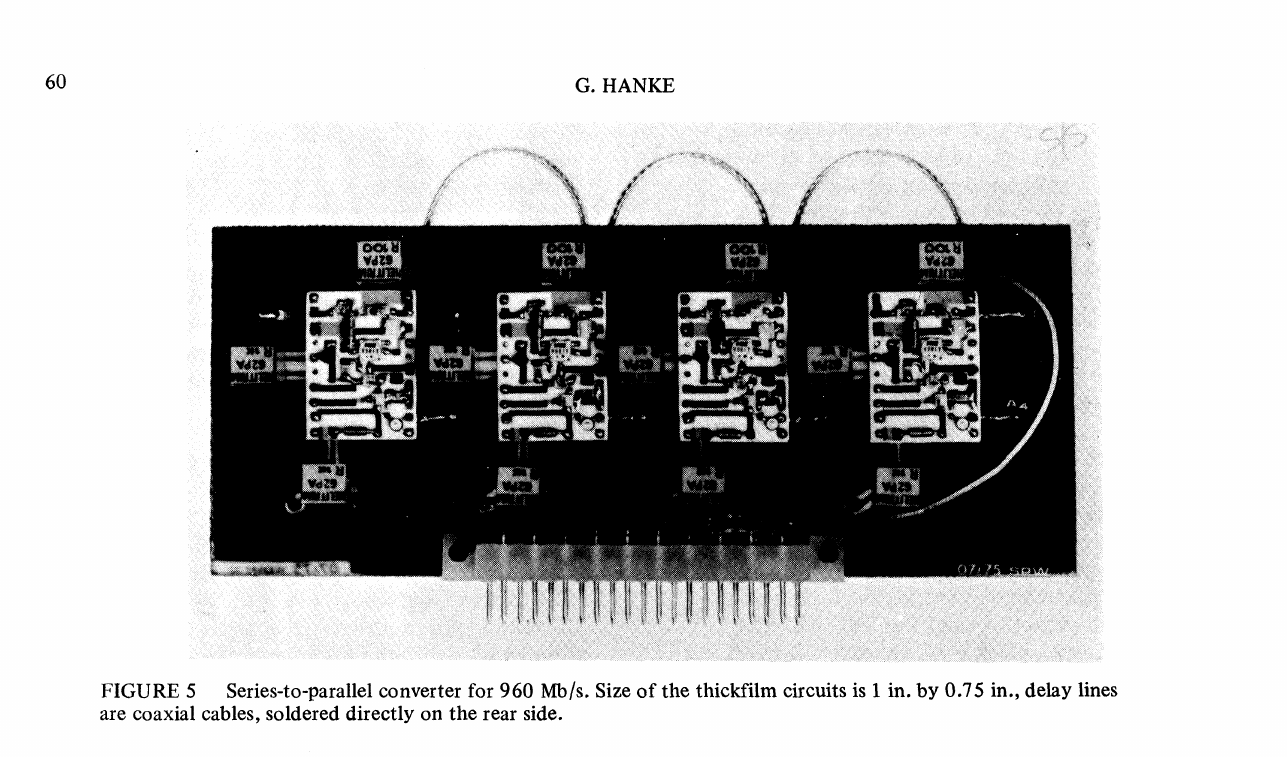
FIGURE 5 Series-to-parallel converter for 960 Mb/s. Size of the thickfilm circuits is in. by 0.75 in., delay lines are coaxial cables, soldered directly on the rear side.